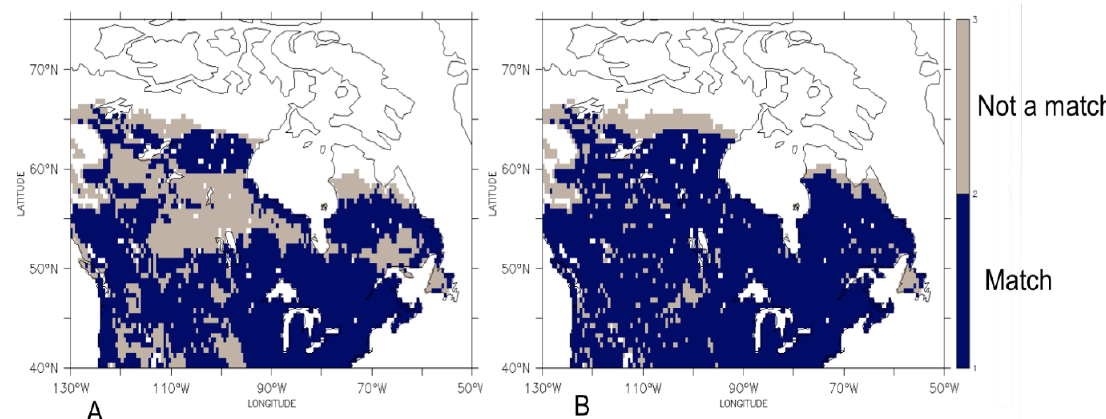
Figure 5. Map comparisons of predicted dominant PFT distribution in the final simulation year for directed dispersal and standard disturbance with a dispersal rate of ( A ) 0.1 km and ( B ) 10 km to the equilibrium response.